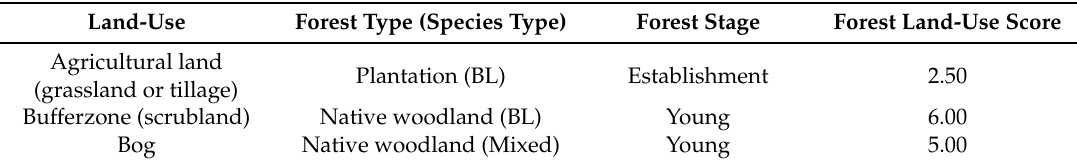
Table A13. Summary of recreation scores for non-forest, including the equivalent forest type and forest